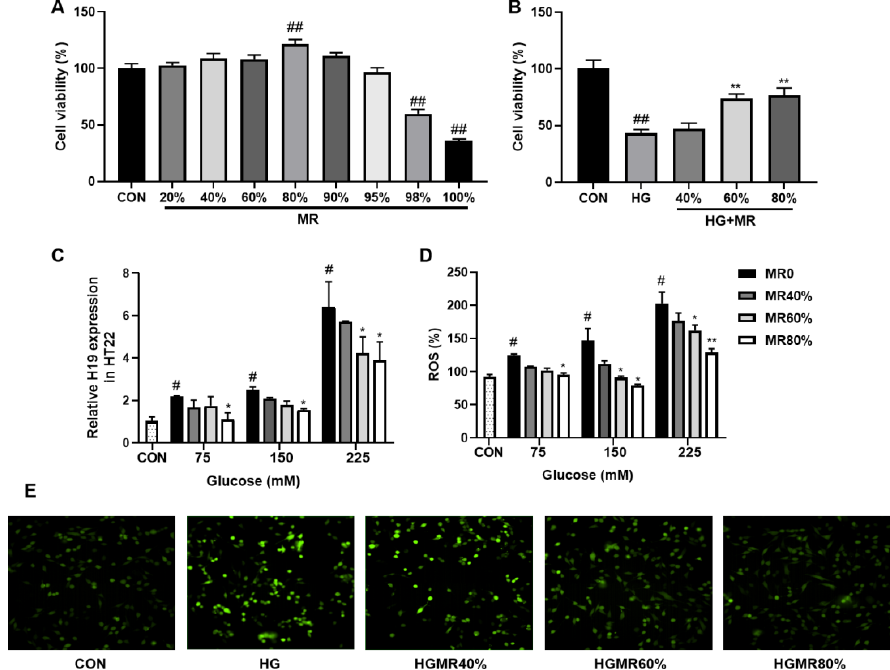
Figure 5. Effects of MR on the expression of H19 induced by high glucose in HT22 cells. ( A ) HT22 cell viability treated with different levels of MR. ( B ) HT22 cell viability treated with HG (225 mM) and different levels of MR. ( C ) Relative H19 expression of HT22 cells treated with different concentrations of glucose and different levels of MR. ( D ) Relative ROS levels of HT22 cells treated with different concentrations of glucose and different levels of MR. ( E ) DCFH fluorescence in HT22 cells treated with HG (225 mM) and different levels of MR. All data are shown as the mean ± SEM. # p < 0.05, ## p < 0.01 (versus CON); * p < 0.05, ** p < 0.01 (versus HG).